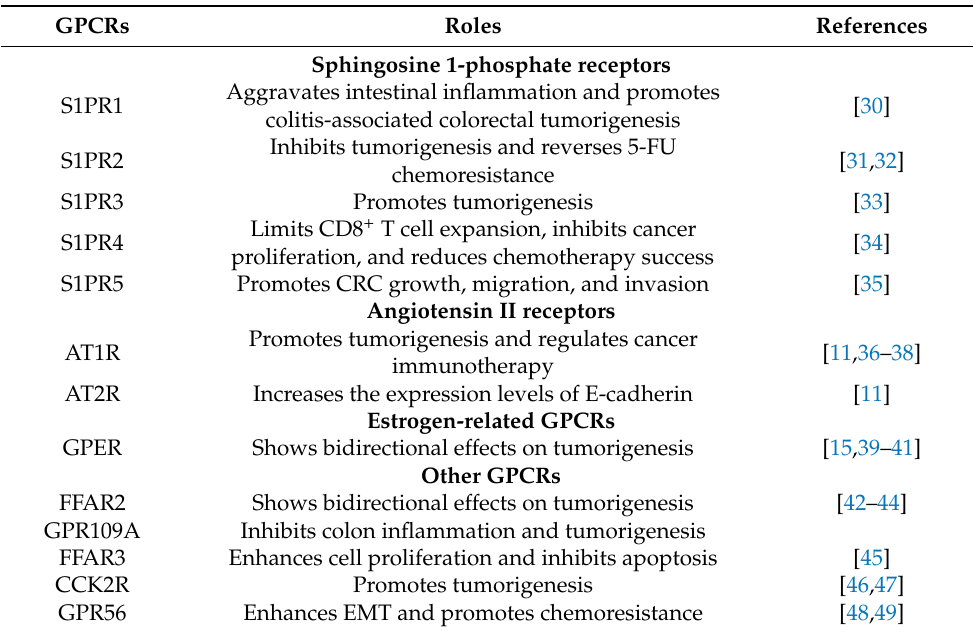
Table 1. Roles of G protein-coupled receptors in colorectal cancer.